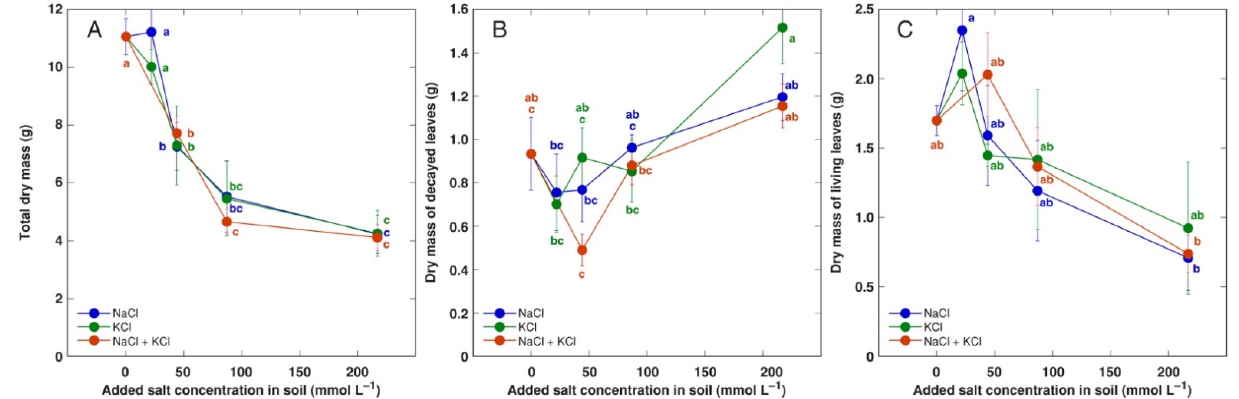
Figure 5. Effect of added NaCl, KCl and NaCl + KCl concentration in soil on total dry mass ( A ), dry mass of decayed leaves ( B ) and dry mass of living leaves ( C ) of Armeria maritima plants from accession AM3 after 7 weeks of cultivation. Data are means ± SE from 5 replicates. Different letters of respective color between accessions and treatments indicate statistically significant differences ( p < 0.05). Table 4. Effect of salinity treatment on morphological parameters of Armeria maritima accession AM3 cultivated for 7 weeks in